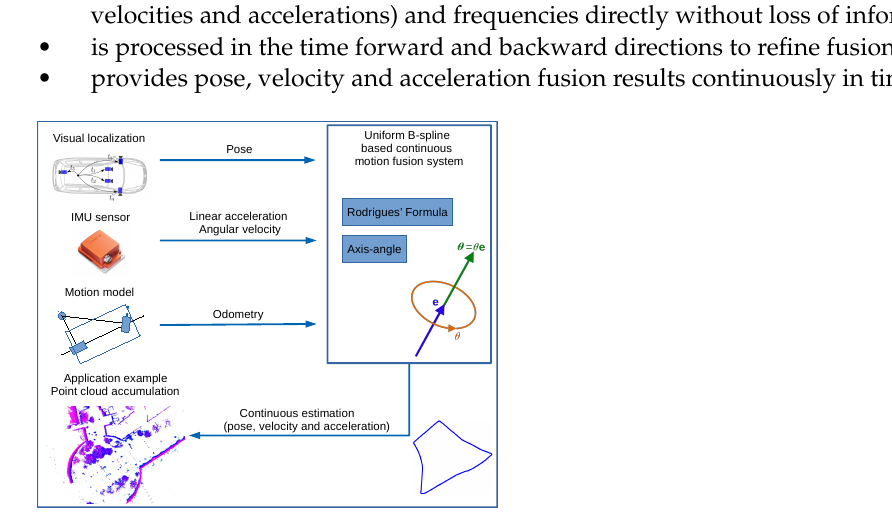
Figure 1. An application example of applying our Uniform B-spline-based continuous motion fusion approach. Our approach can apply pose, velocity and acceleration measurements with different frequencies to optimize two uniform B-splines S t and S r (translation and rotation). Afterwards, the fused pose, velocity and acceleration results can be estimated continuously in